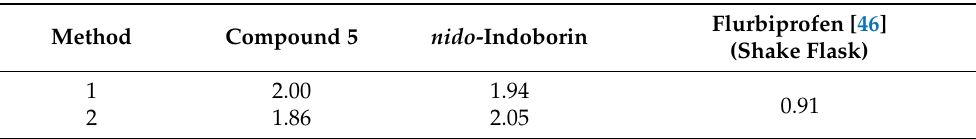
Table 2. LogD 7.4 of compound 5 and nido -indoborin. Method 1: Chromolith Speed ROD RP-18E 50